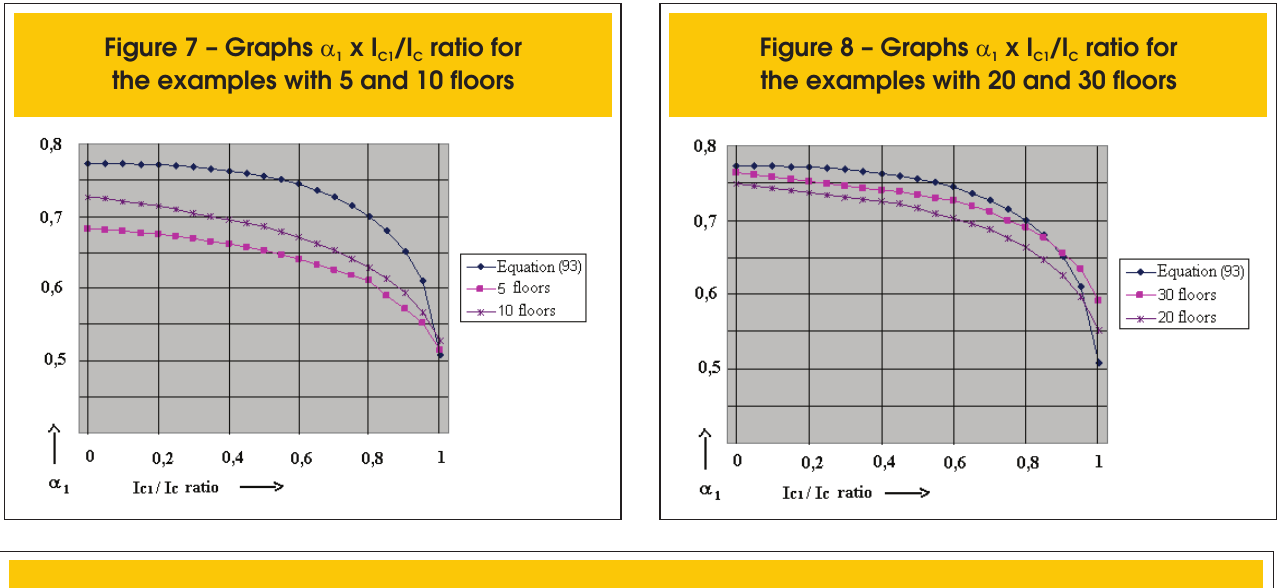
Figure 7 – Graphs a x I /I ratio for 1 C1 C the examples with 5 and 10 floors